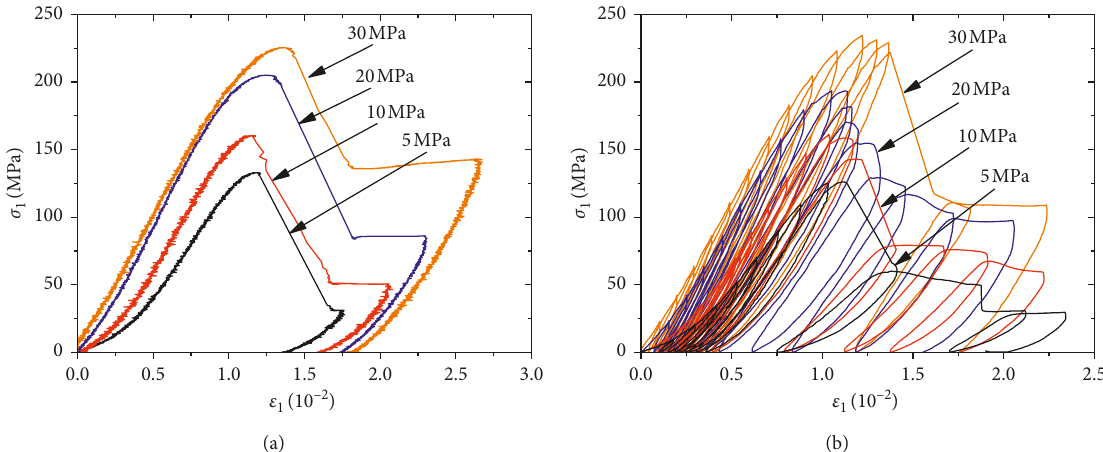
Figure 4: The axial stress-strain curves from (a) conventional triaxial compression tests and (b) cyclic loading-unloading triaxial com- pression